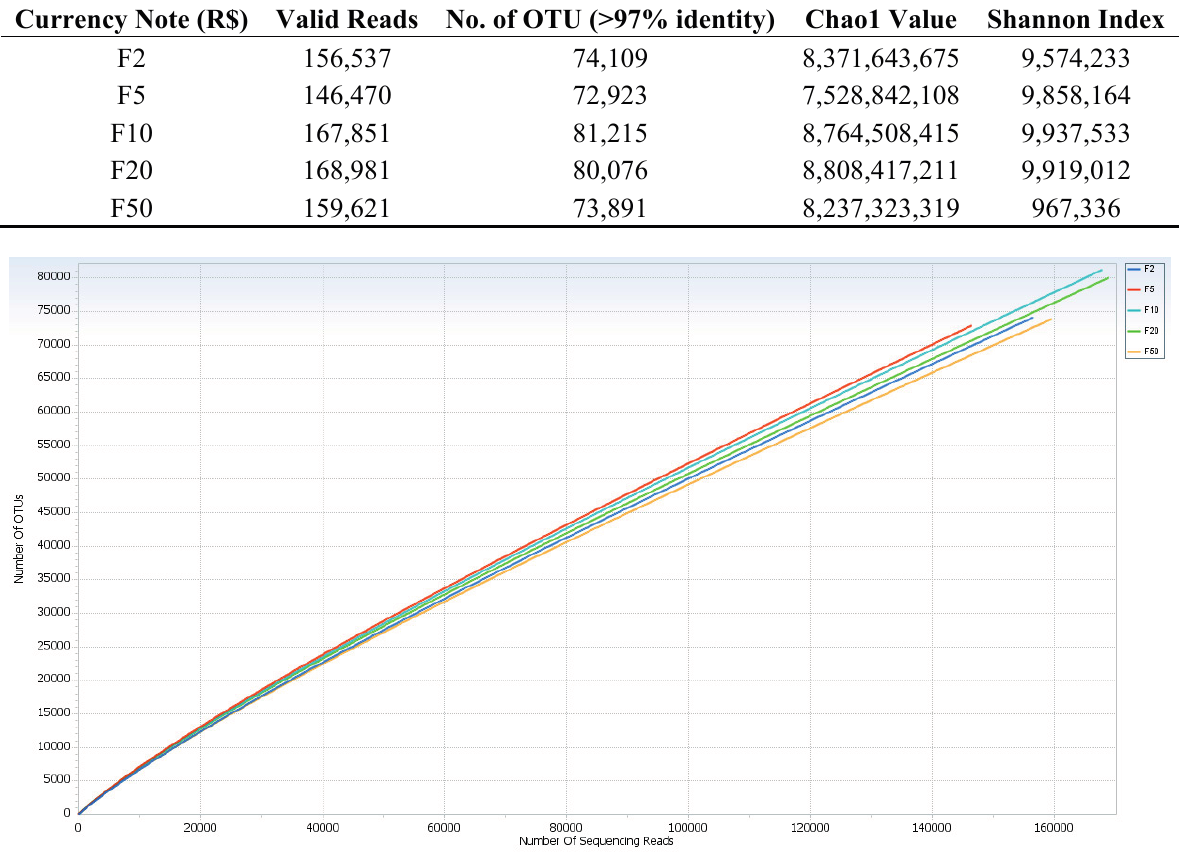
Figure 1. Rarefaction analysis of the five samples. Rarefaction curves of OTUs clustered at 97% sequence identity across the